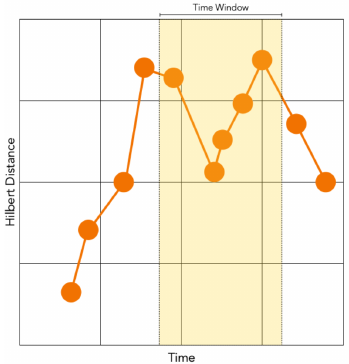
Figure 7. We used equally spaced time window bins to split a scanpath consisting of Hilbert distance and duration tuple values ( h , d ) into combinatorial segments. In cases where a fixation’s duration exceeds the time bin size, its duration is truncated; the fixation and its remaining duration are copied over to the next